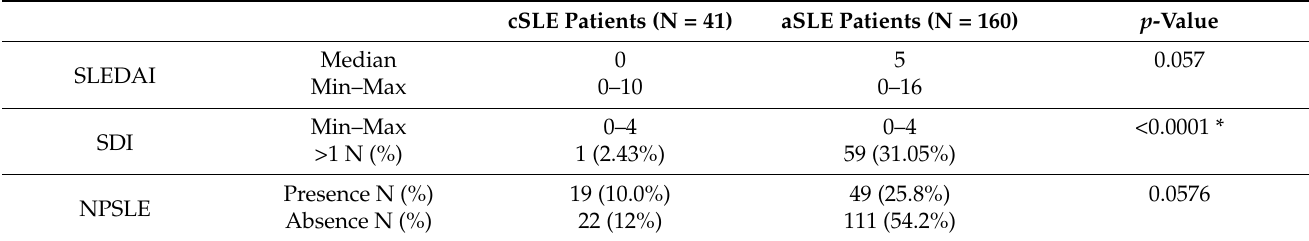
Table 7. Descriptive clinical outcomes in aSLE and cSLE (N =